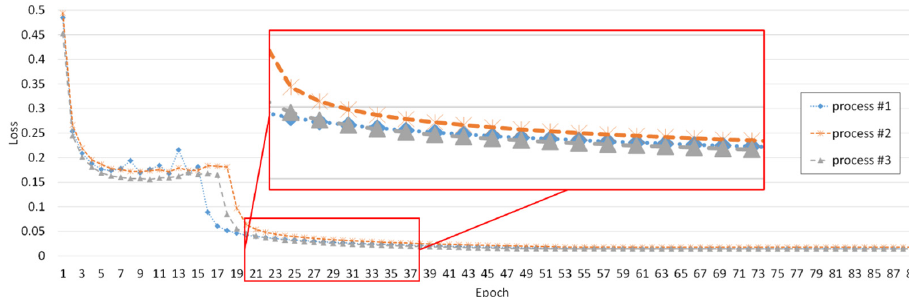
Figure 13. Loss of training data.